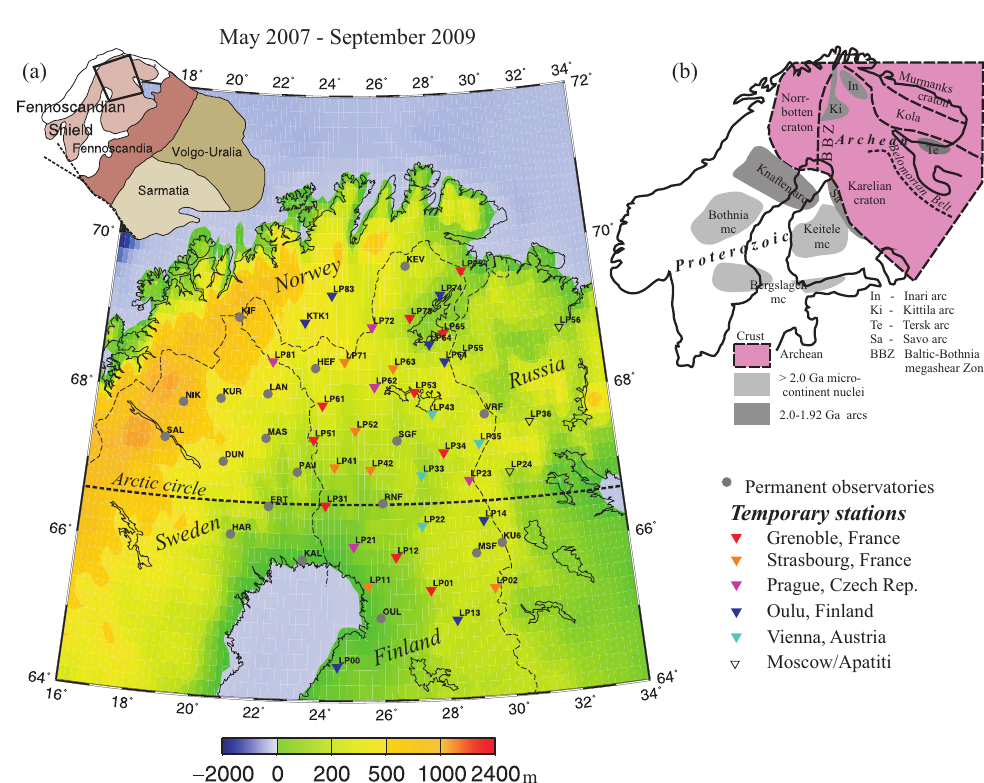
Fig. 1 Fig. 1. POLENET/LAPNET network of broad-band seismological stations (a) and micro-continental nuclei (mc), island arcs and boundaries of hidden and exposed suspect terranes in the Fennoscandian Shield older than 1.92Ga (b) , (redrawn according to Korja et al.,